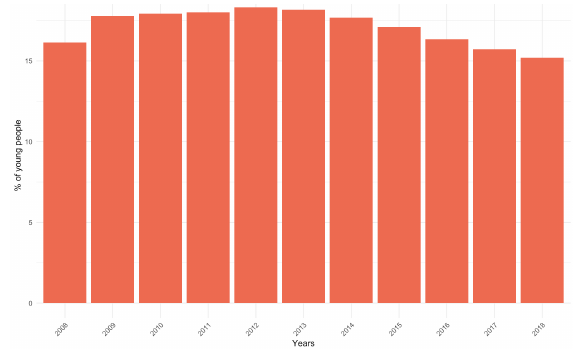
Figure 1: European % average of young people neither in employment nor in education and